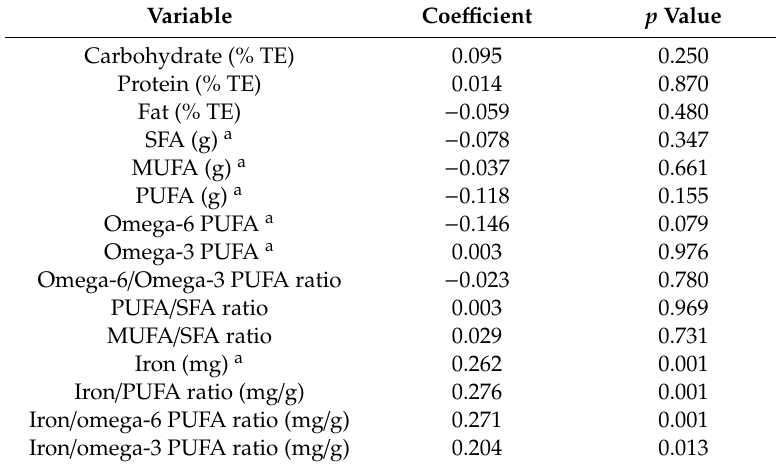
Table 3. Correlation analysis between MNSI-PE scores and mean daily intake of energy and